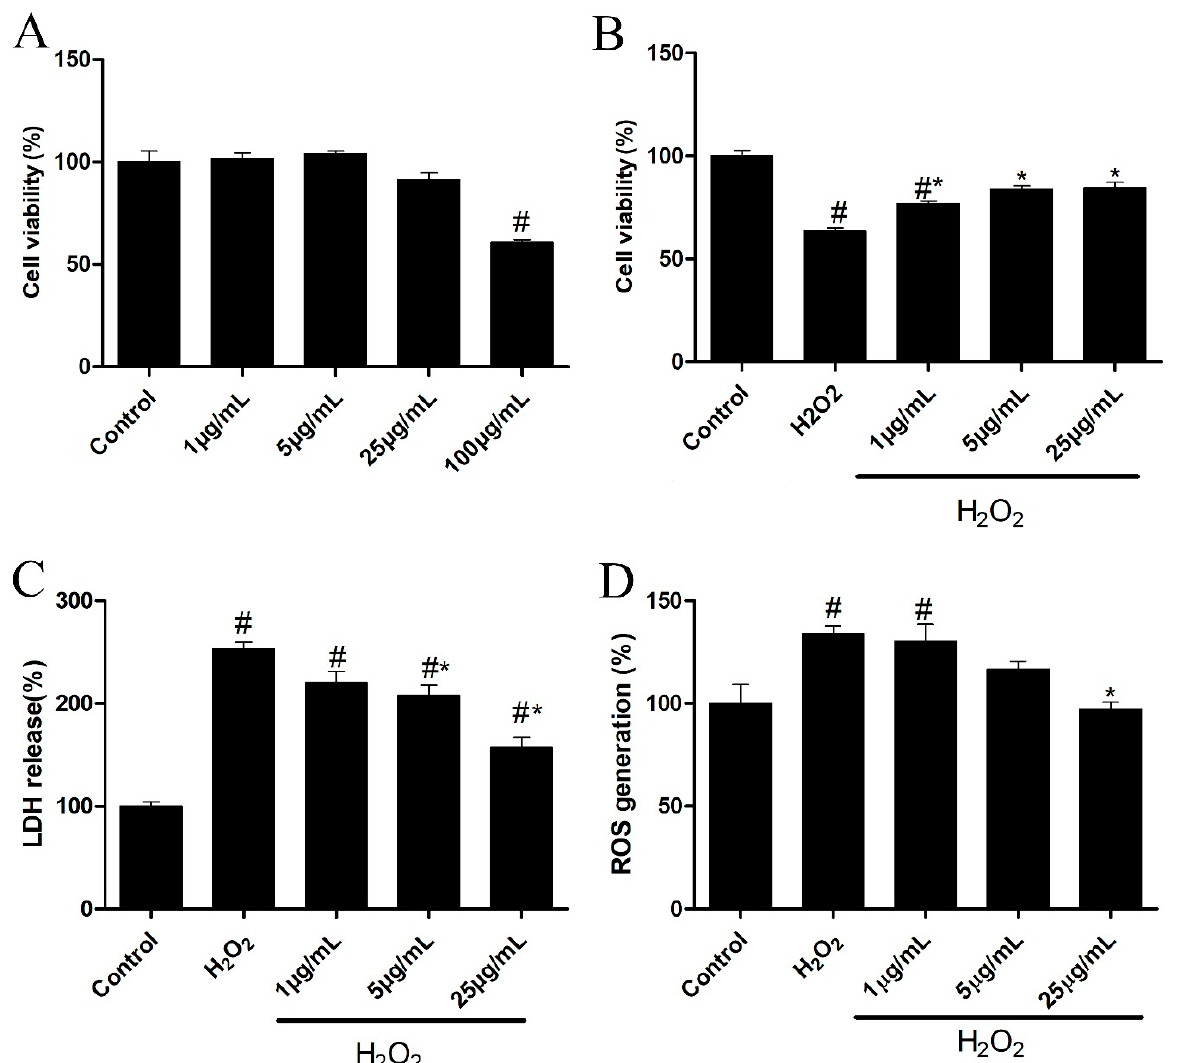
Figure 10. Effects of OLNZ in H 2 O 2 -induced neuronal cell death in vitro: ( A ) The non-toxic concentration of OLNZ in SH-SY5Y cells was estimated using the MTT assay; ( B ) Cell viability in H 2 O 2 -mediated toxicity was also evaluated using the MTT assay; ( C ) The release of cytotoxic marker LDH (%); and ( D ) the oxidative stress marker ROS was examined. Data were expressed as the mean ± SEM, and the experiment was repeated three times. # and * indicate a statistically significant difference compared with the control and H 2 O 2 treatment alone, respectively, p < 0.05. the oxidative stress marker.